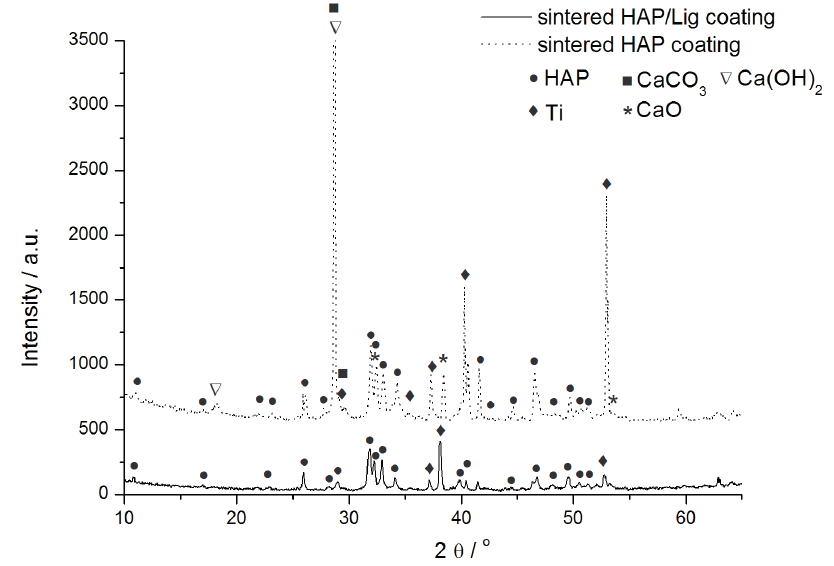
Figure 2. X-ray diffraction (XRD) patterns of sintered HAP and HAP/Lig (1 wt % Lig)